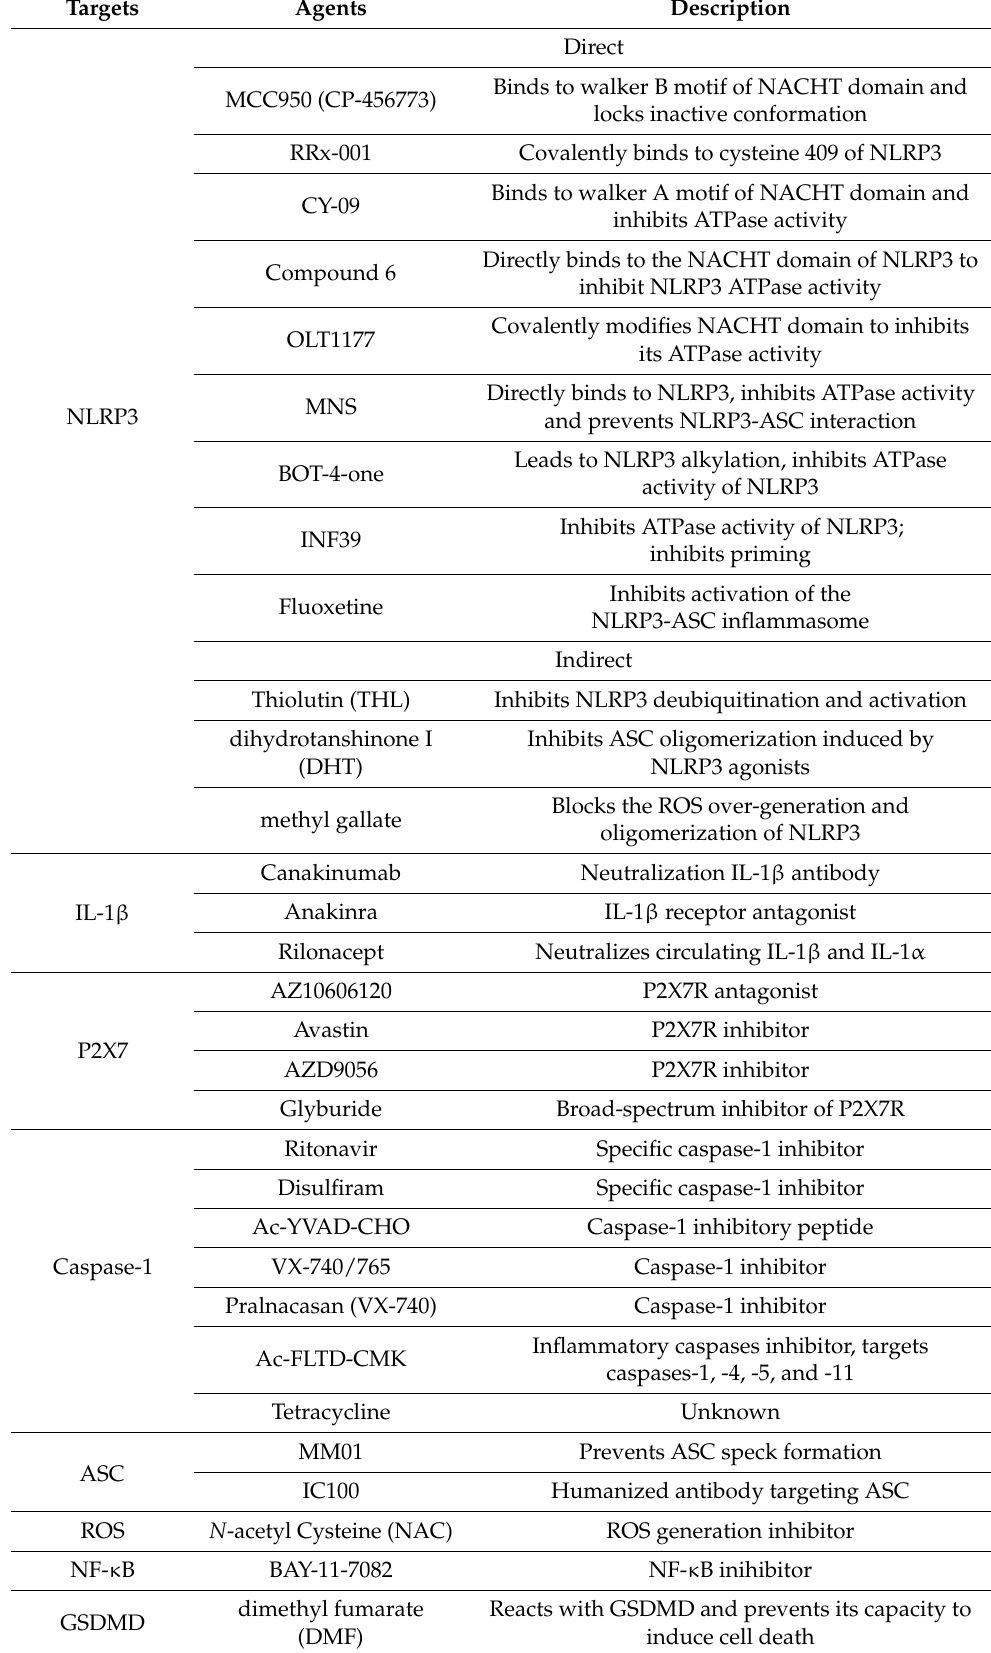
Table 1. Small molecule inhibitors targeting NLRP3 inflammasome